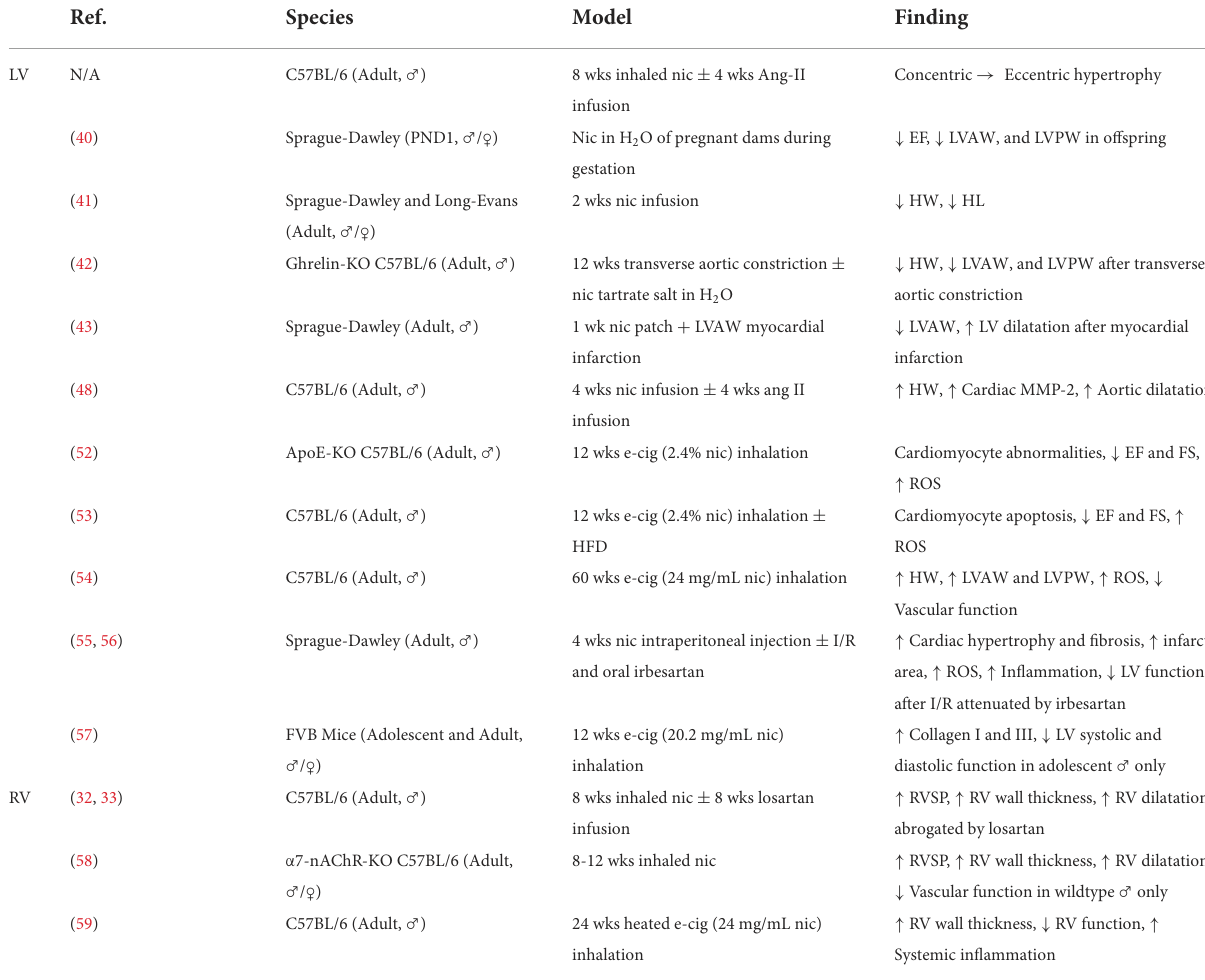
TABLE 1 Summary of animal studies demonstrating cardiac structural and functional changes associated with nicotine and novel tobacco products.